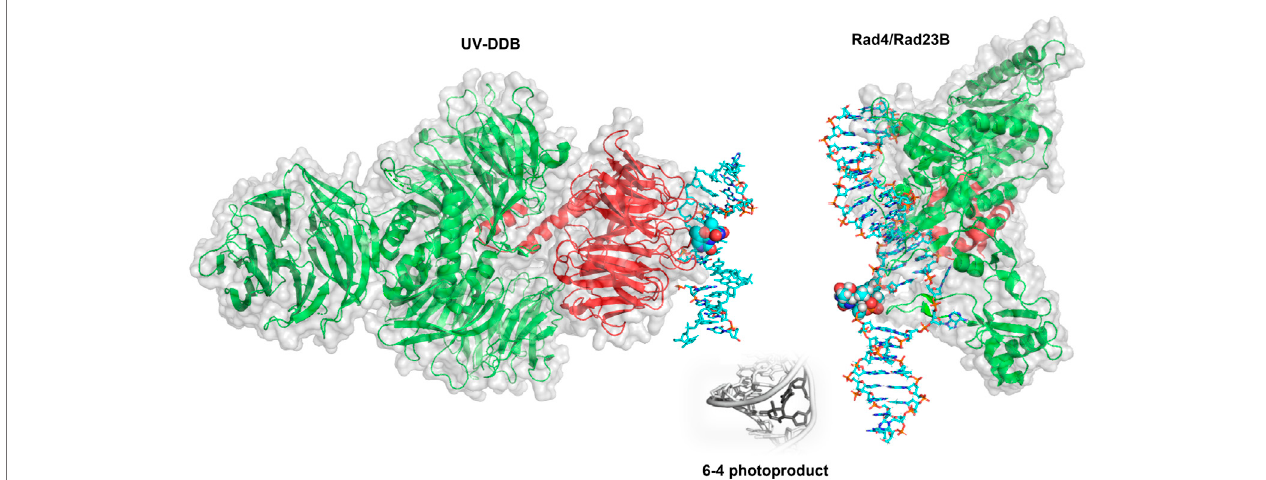
FIGURE 6 | Crystal structures of UV-DDB and Rad4/Rad23 bound to damaged DNA. (Left) DDB1 (green cartoon) and DDB2 (red cartoon) form a UV-DDB heterodimer.Inthisstructure,UV-DDBisboundtoDNA(cyansticks)witha6-4photoproductandadjacentbase fl ippedintotherecognitiondomain(spherescoloredby atom). Structure taken from PDB ID: 3EI1. (Right). Crystal structure of Rad4/Rad23 (green and red cartoons, respectively) bound to a UV-induced 6-4 photoproduct containing DNA (cyan sticks). The 6-4 photoproduct is displayed as spheres. Structure taken from PDB ID: 6CFI. While it is widely believed to occur, the direct hand-off of a 6-4 photoproduct from UV-DDB to XPC has not been directly observed by single molecule